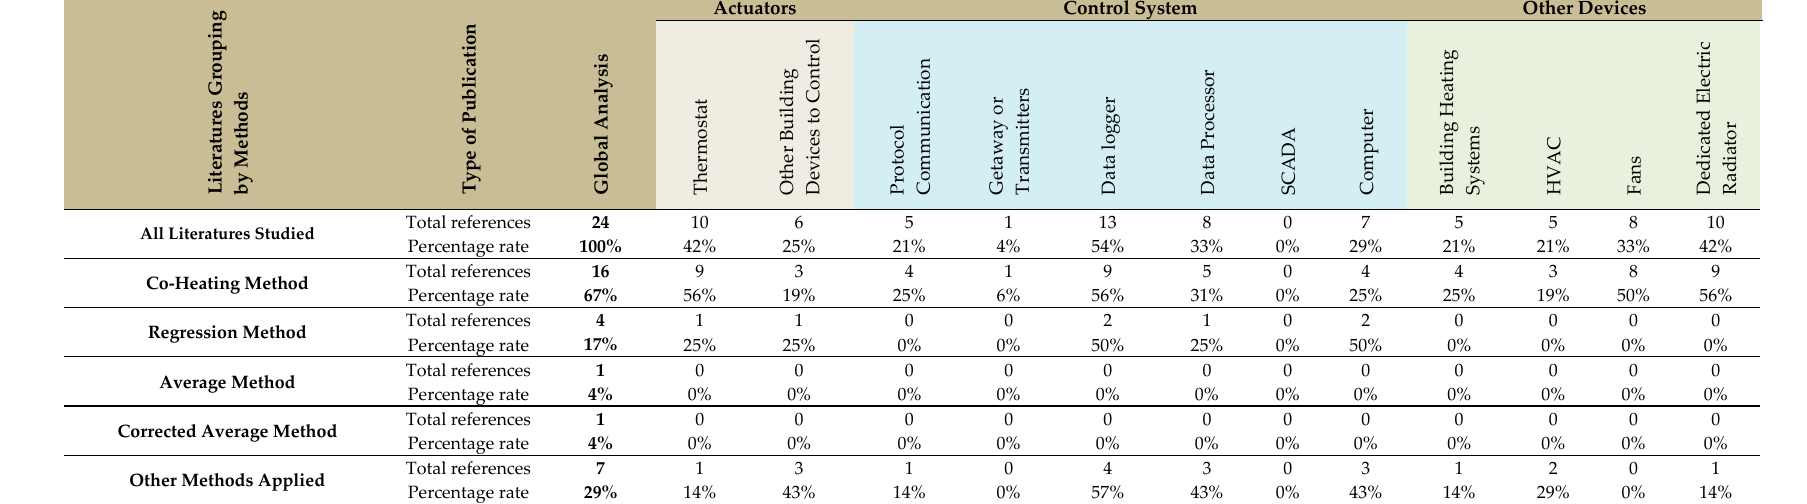
Table 15. Quantitative analysis of references studied by methodology: Global analysis of the method, actuators, controls systems, and devices used in each methodology.